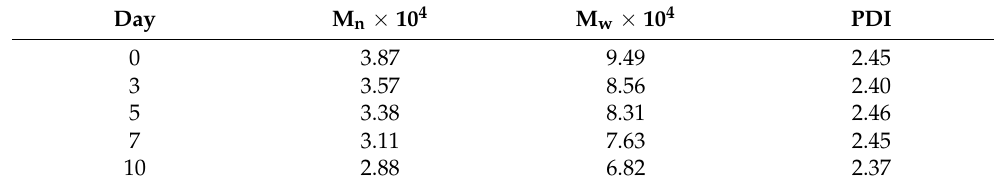
Table 3. Change in molecular weight of PBS films, analyzed using gel permeation